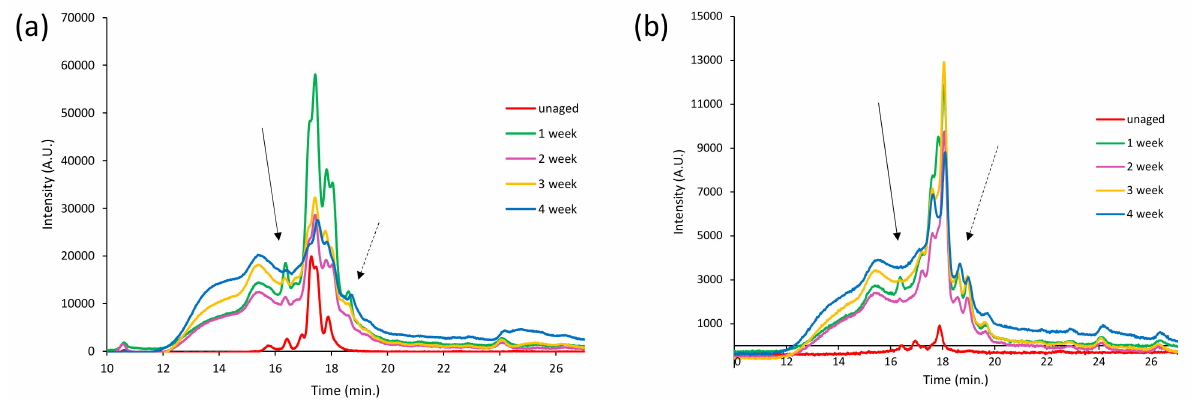
Figure 12. SEC chromatograms (10–27 min) of the MeOH extracts of PS-0w (red), PS-1w (green), PS-2w, PS-3w (yellow), and PS-4w (blue) acquired at 260 nm ( a ) and 340 nm ( b